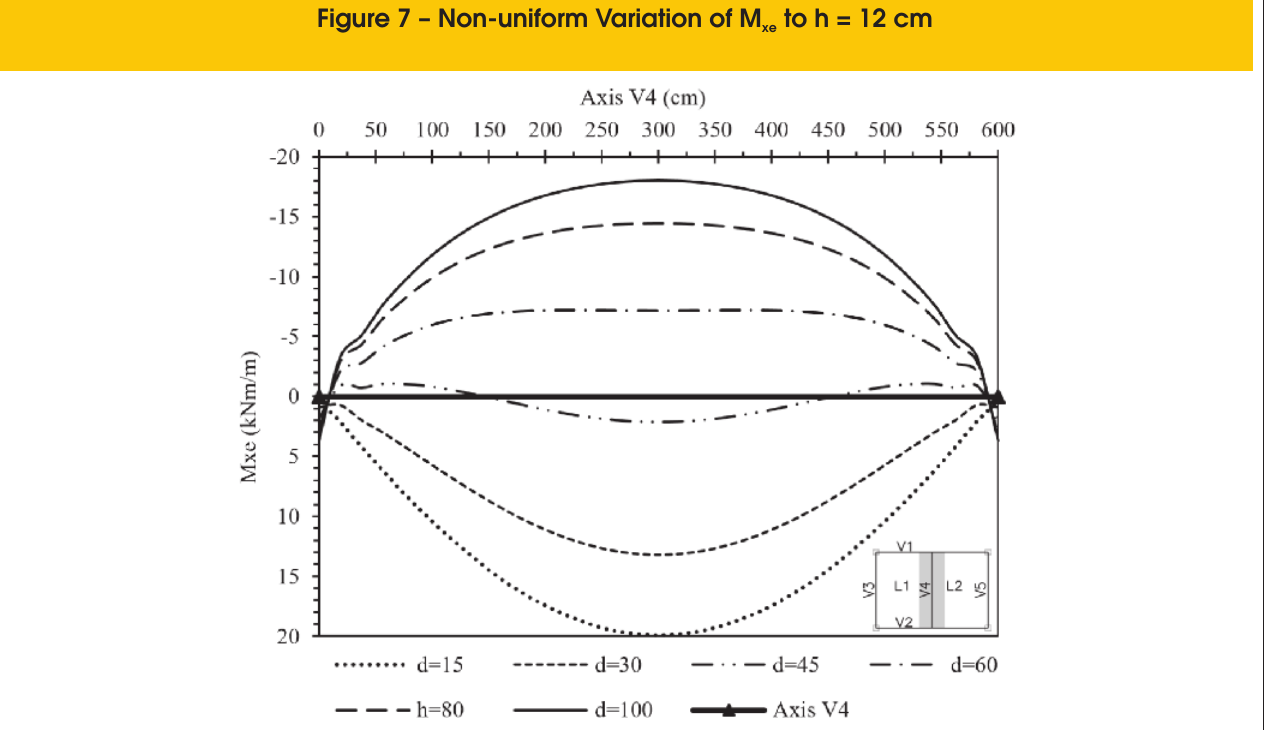
Figure 7 – Non-uniform Variation of M to h = 12 cm